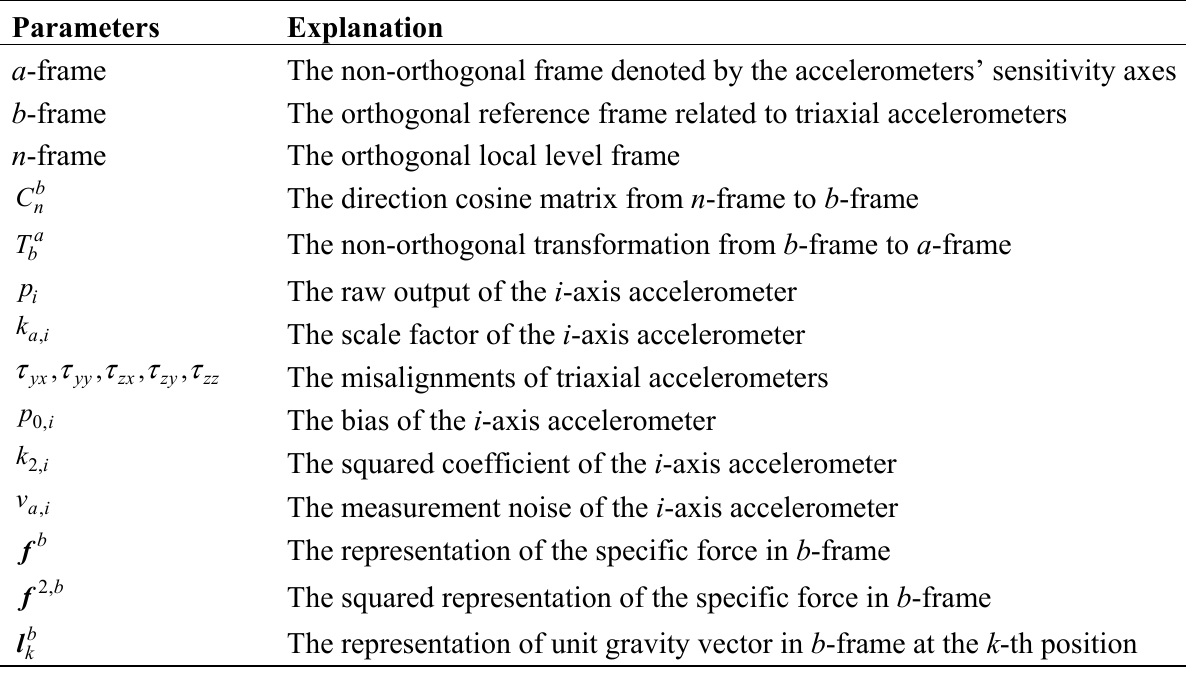
Table 1. Definition of the related